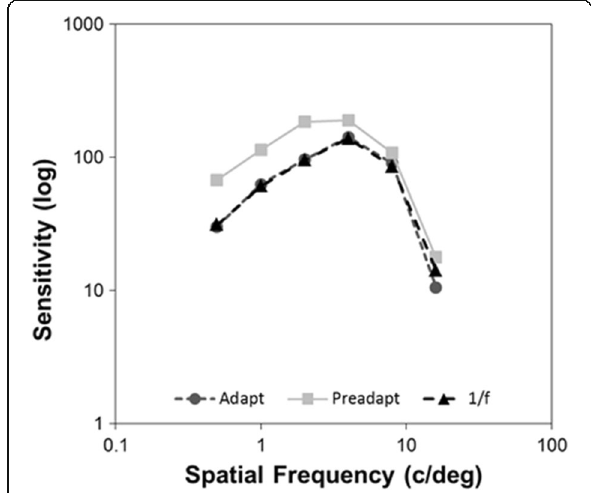
Fig. 5 CSF following neutral, gray-field adaptation ( light gray squares ), adaptation to the original mammogram scans ( dark gray circles ), and adaptation to mammogram images filtered to have a slope of − 1 ( black triangles ). Points show the mean settings for the five